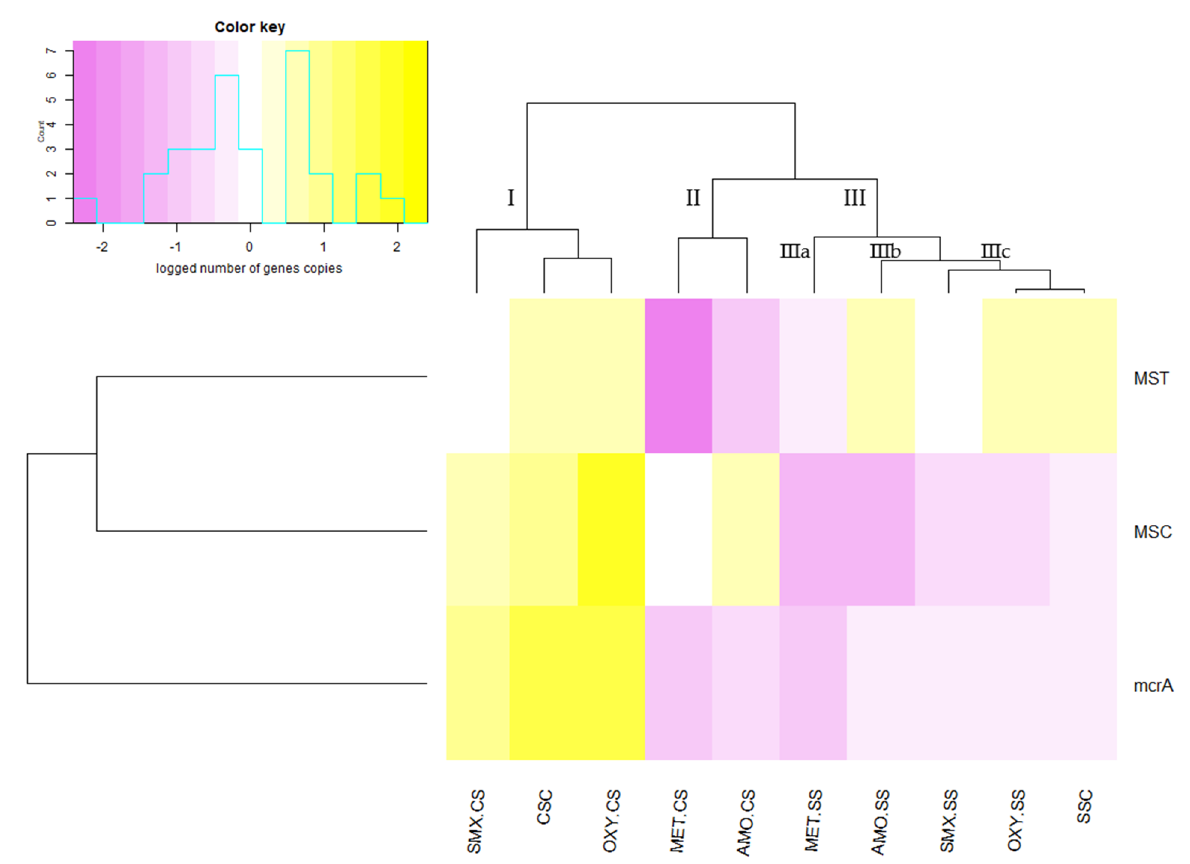
Figure 4. Heatmap with the logged concentrations (number of copies in g D − 1 ) of MST , MSC and mcr A genes in process and control bioreactors with sewage sludge (SS) and cattle slurry (CS). (SSC) control samples of sewage sludge, (CSC) control samples of cattle slurry.